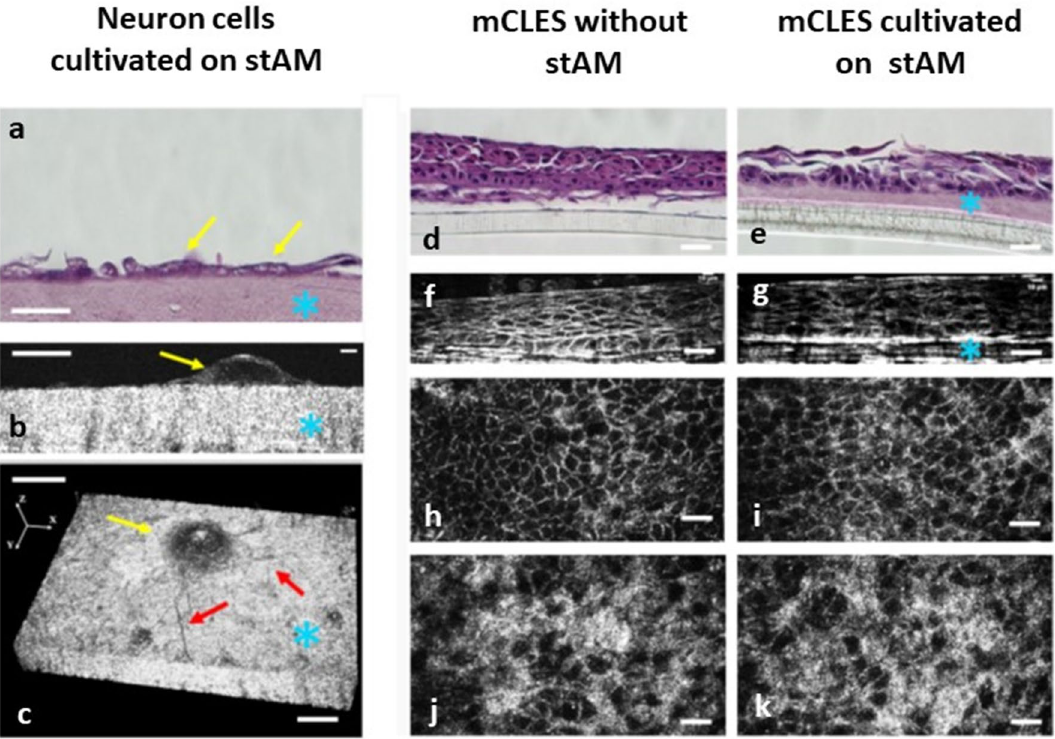
Figure 4. The effects of the stAM on the imaging quality taken by FF-OCT. ( a–c ) Neuron cells (N2A) cultivated on the stAM. ( a ) Hematoxylin and eosin (H&E) staining of cross-sectional neuron cells cultivated on the stAM. Yellow arrow: neuron cells. Blue star: stAM. ( b ) A 2D cross-sectional FF-OCT image of neuron cells cultivated on stAM. Yellow arrow: neuron cells. Blue star: stAM. ( c ) A 3D FF-OCT image of neuron cells cultivated on stAM. Yellow arrow: cell body of the neuron cell. Red arrows: neuron processes. Blue star: stAM. ( d–k ) The effects of the stAM on the FF-OCT cross-sectional and en face imaging quality of cultivated mCLES. ( d , e ) H&E staining of the cross-sectional mCLESs with or without stAM as the matrix. Blue star: stAM. ( f , g ) A 2D cross- sectional FF-OCT images of mCLESs with or without stAM as the matrix. Blue star: stAM. ( h–k ) Sequential FF-OCT en face images at 5 μm ( h , i ) and 30 μm ( j , k ) above the bottom of the basal epithelial cells. Scale bar = 20 μm. mCLESs: multilayered cultivated limbal epithelial